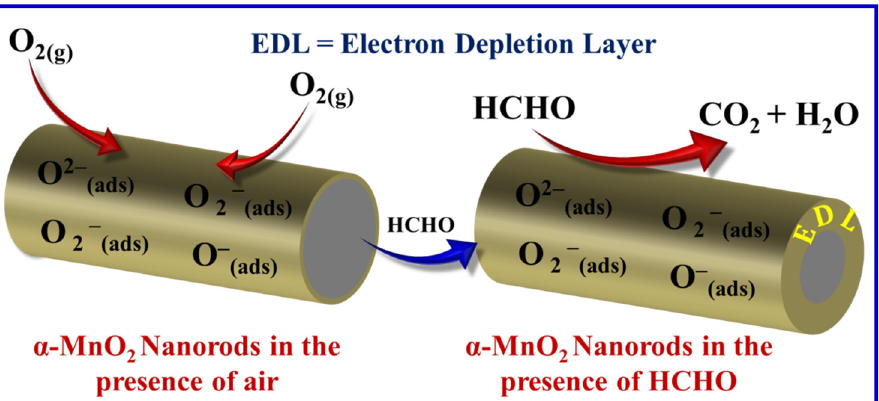
2 nanowire-based gas